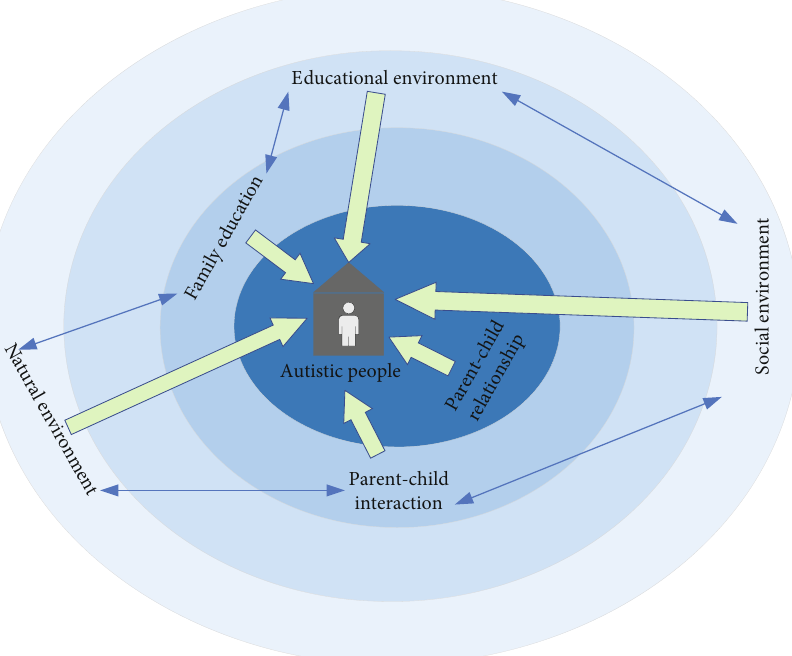
Figure 1: Relationship between the population and the environment of autism.